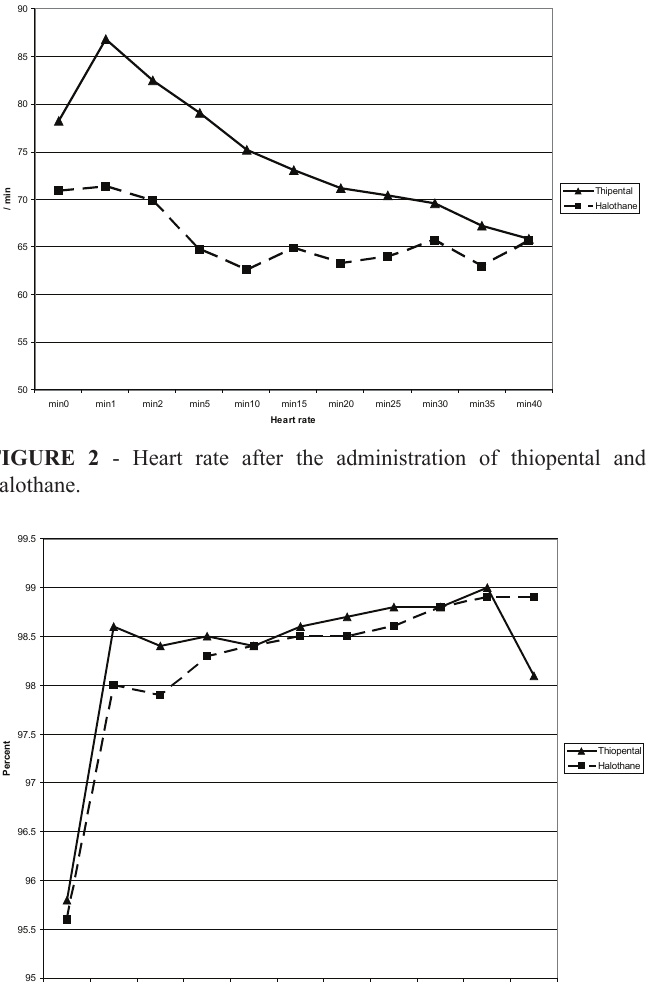
saturation after the administration of thiopental 2